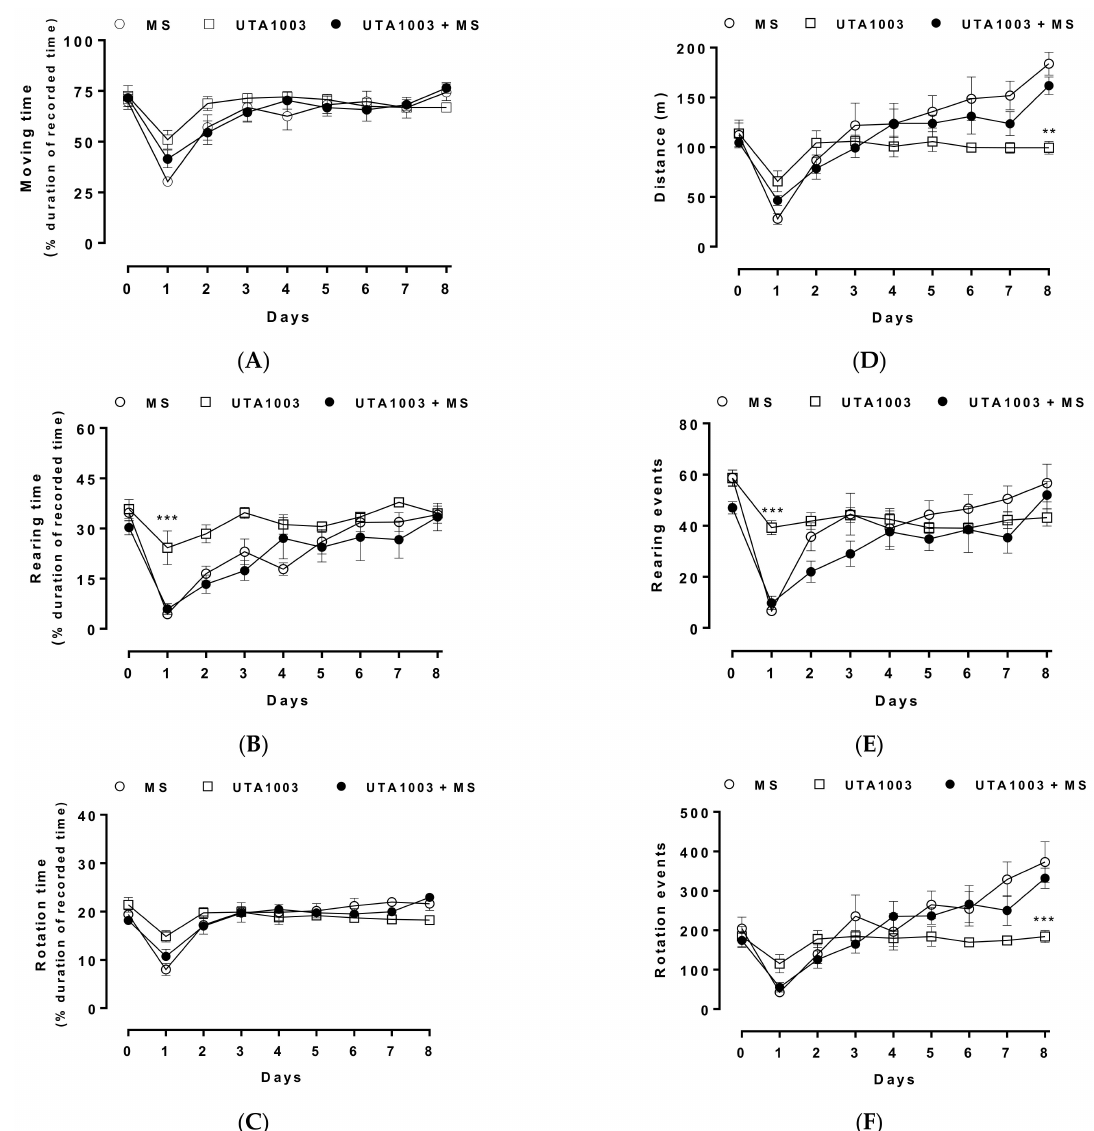
Figure 8. Motor behavioural effects of chronic administration of morphine and UTA1003. Open- field motor behavioural effects after twice-daily subcutaneous injections of UTA1003 (24.6 mg/kg), morphine (MS, 3.0 mg/kg), or their combination were measured in Sprague Dawley rats. Opioid- induced behavioural activities were measured daily at 30 min post injection over a period of 8 days, as described in the methods. Several behavioural parameters, such as moving time ( A ), rearing time ( B ), rotation time ( C ), distance travelled ( D ), rearing numbers ( E ), or rotation numbers ( F ), were measured. Statistically significant differences for the same time point between the effects of MS and UTA1003 are shown as ** p < 0.01 and *** p < 0.001 were calculated using one-way ANOVA with Bonferroni’s multiple comparisons. Values are presented as mean ± SEM (n = 6 animals per